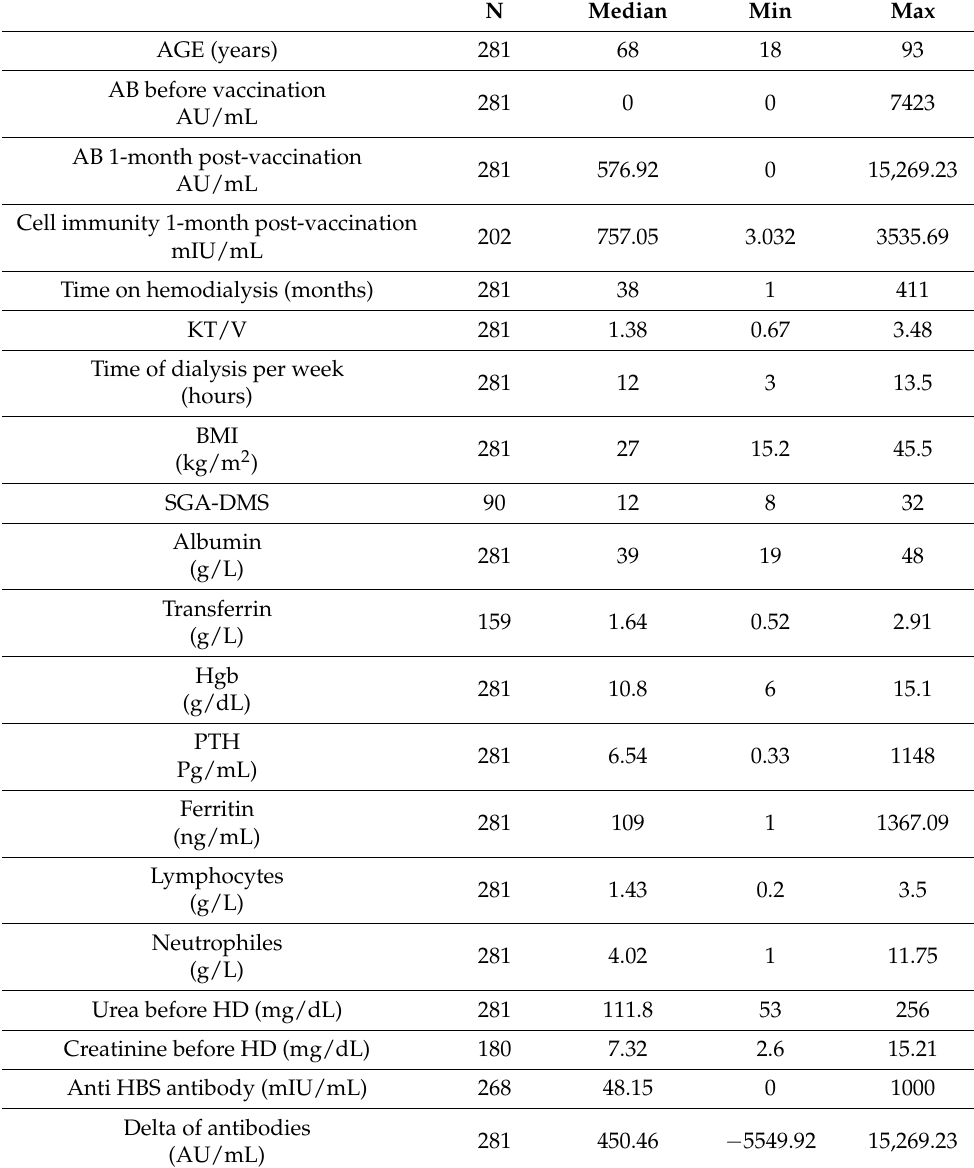
Table 1. Characteristics of the study